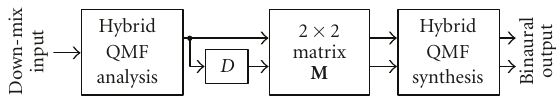
Figure 6: Overview of a binaural synthesis stage based on a mono